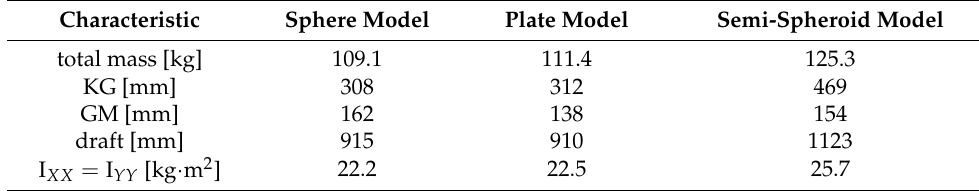
Table 2. Main properties of the floater.